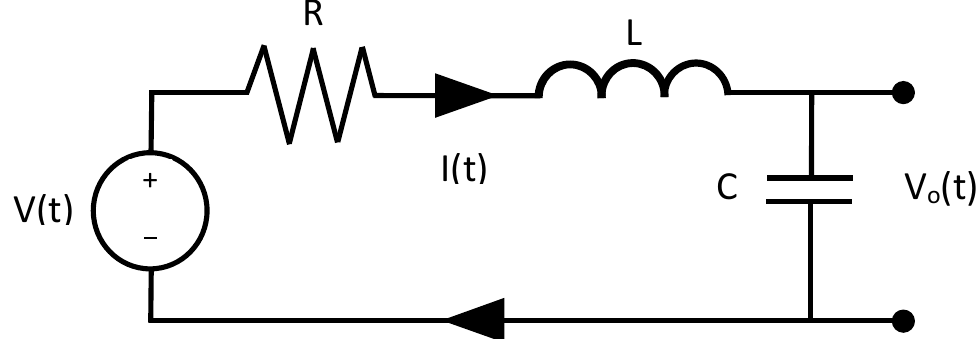
Figure 1. RLC circuit used to obtain the second-order transfer function in electrical